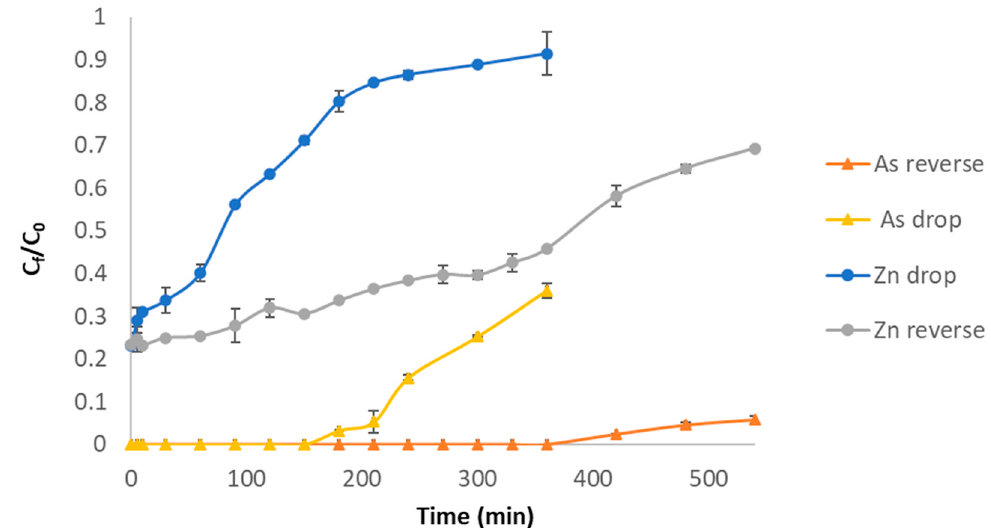
Figure 9. Arsenic and zinc adsorption breakthrough curves of columns with alginate beads containing biogenic iron com- pounds using drop and reverse feeding systems (3 cm of bed height (7.87 g of adsorbent) and 1 mL/min flow rate).